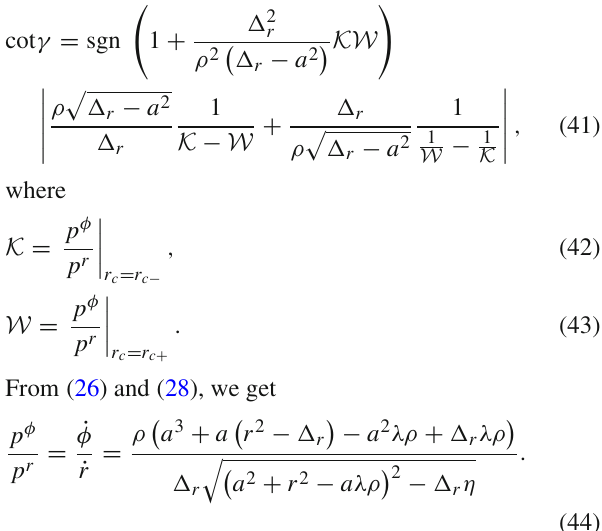
Fig. 9 The shapes of shadows and corresponding distortion parame- ters (cid:15) as function of (cid:13) γ for selected different parameters for distant observers. Here we set M = 1. a Shadows and distortion parameters of rotating Hayward black holes of selected different spin parameters for observers located at r = 40. b Shadows and distortion param- eters of rotating Hayward black holes of selected different magnetic